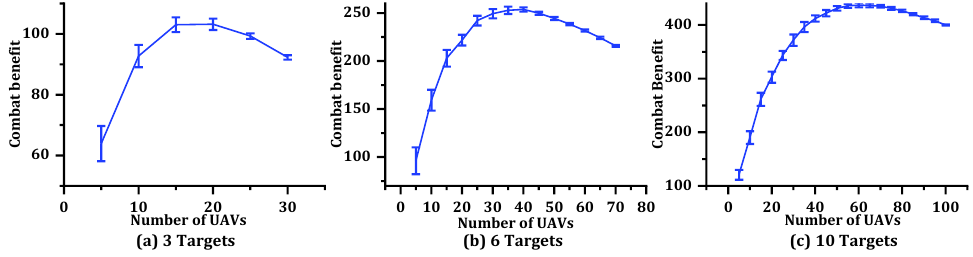
Figure 5. Cost-effectiveness analysis on different number of